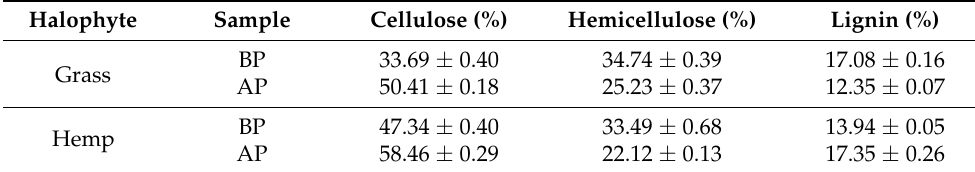
Table 2. Chemical composition of halophyte biomass (% of dry matter); BP: before pretreatment; AP: after